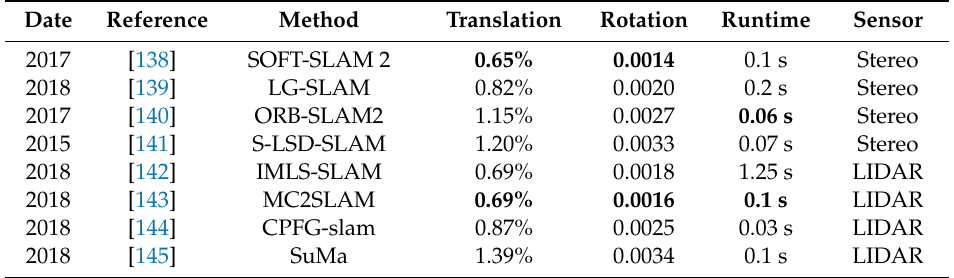
Table 6. SLAM algorithms based on non-deep-learning approaches, as reported on the KITTI website.